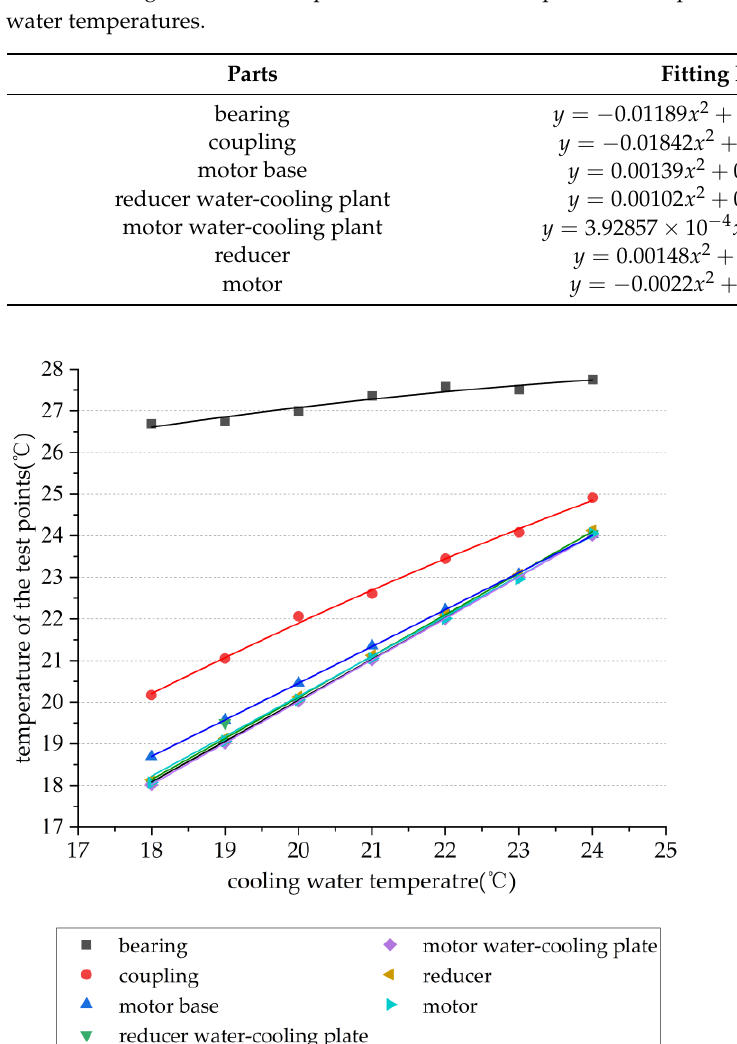
Table 8. Fitting function of temperature measurement points of components under different cooling water temperatures.